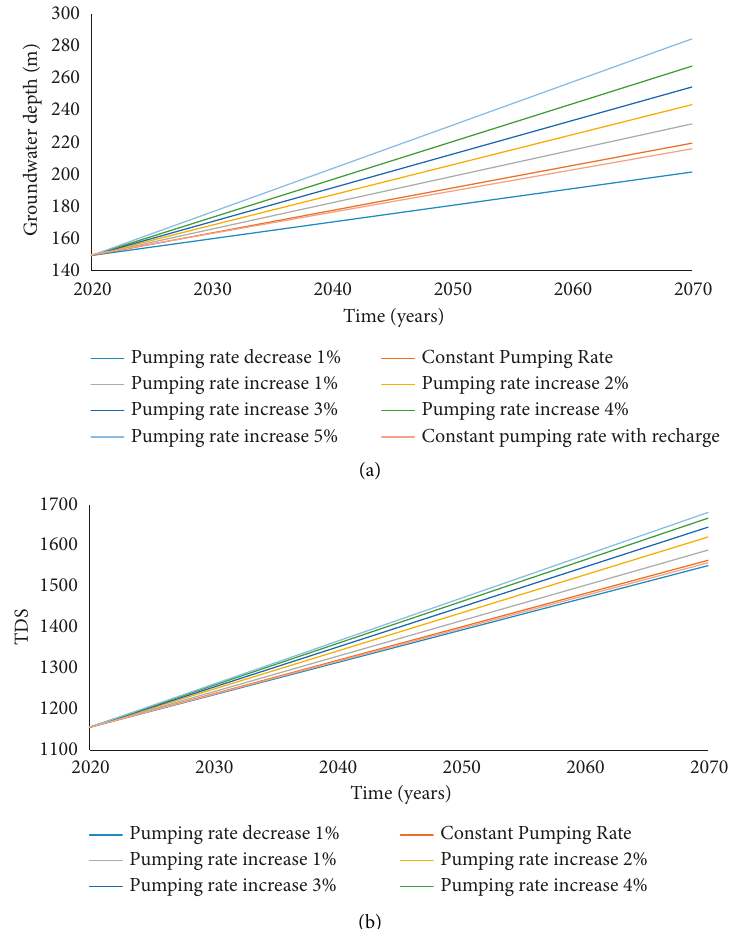
Figure 12: Future prediction results of groundwater depths/aquifer depletion for various pumping rate